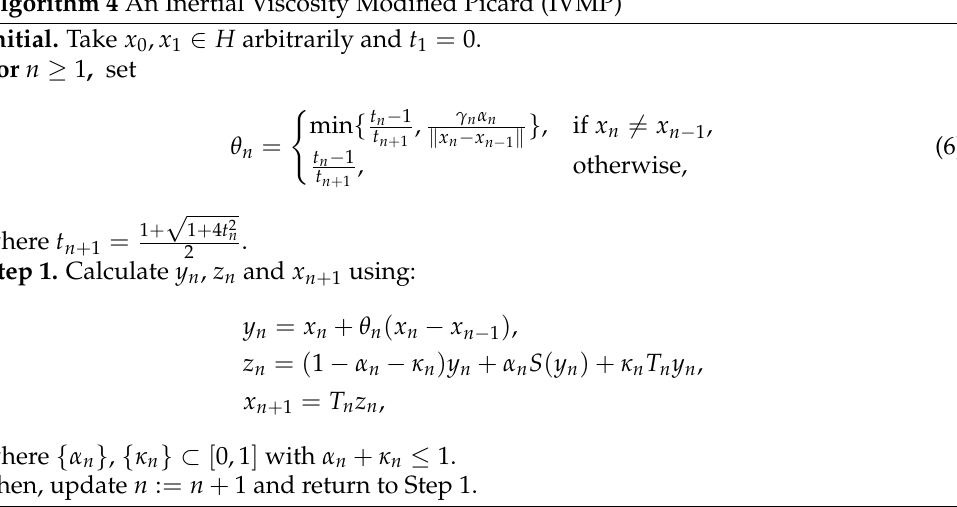
Algorithm 4 An Inertial Viscosity Modified Picard